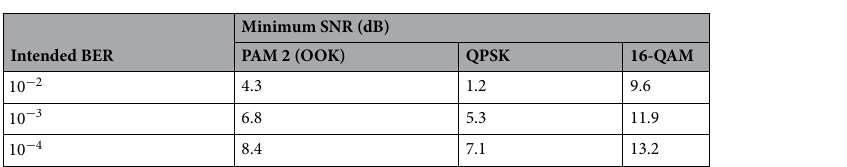
Figure 8. ( a ) Inter-body coupling capacitance ( C C ) with distance, obtained from simulating the model shown in Fig. 5a with varying inter-body distances in ANSYS Maxwell. ( b ) SNR at a snooping device, for a given SNR at the intended receiving device. When the SNR at the snooping device falls below 6–9 dB, successful attack is prevented.